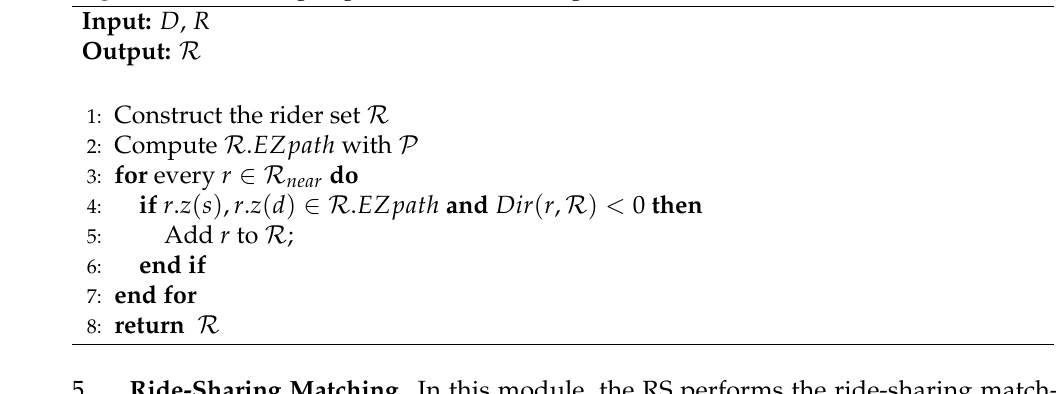
Algorithm 2 Filtering Algorithm with Existing Schedule ( FAES